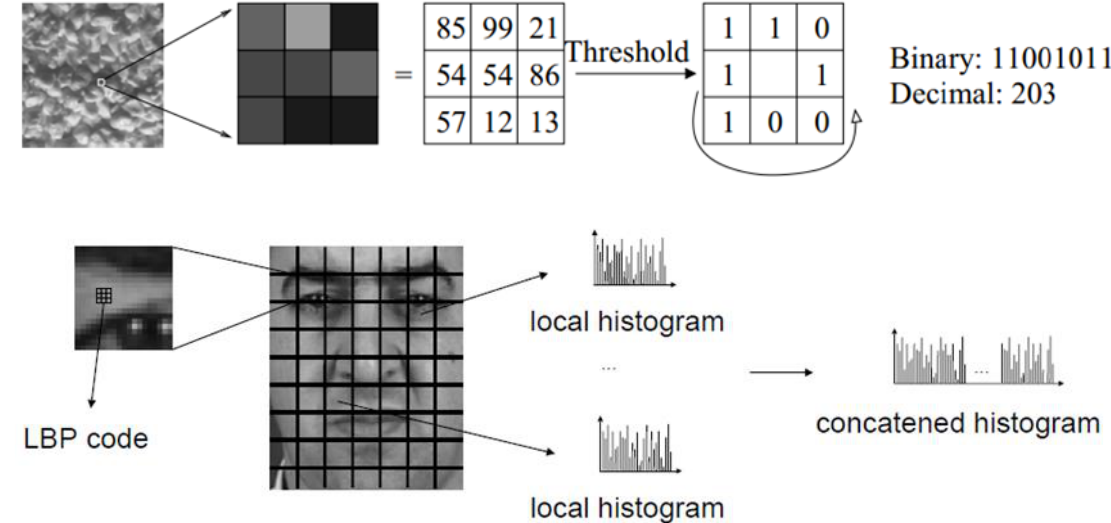
Figure 21. Example of facial local binary pattern (LBP) calculation.